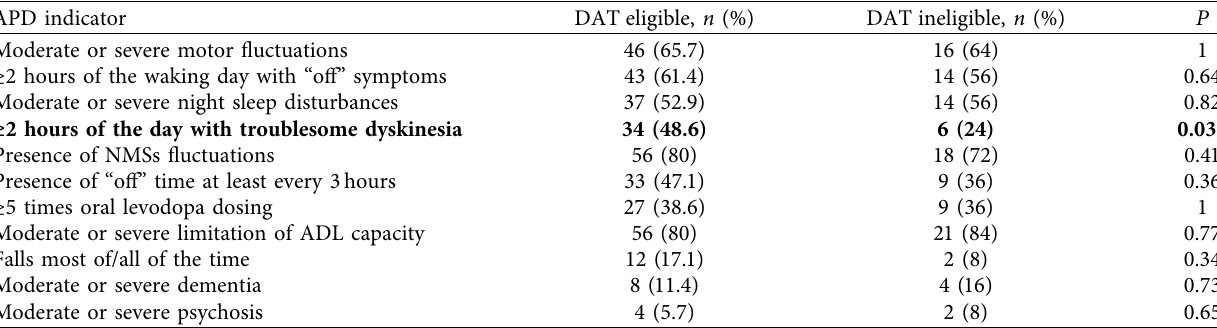
Table 8: DAT eligibility and fulfillment of each APD indicator.